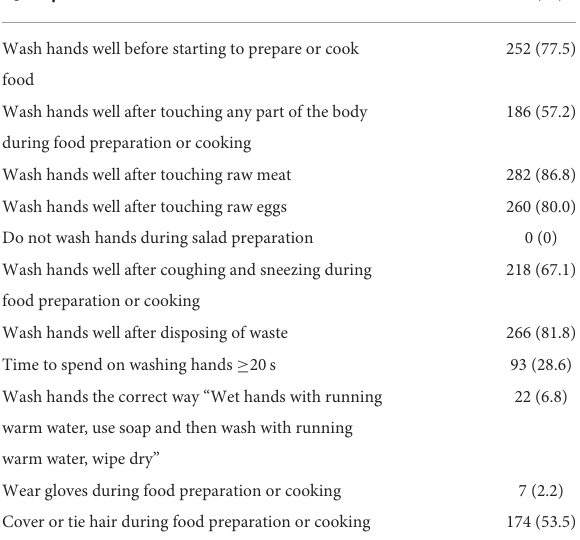
TABLE 3 Query statements and responses a of “personal hygiene” domain ( n =